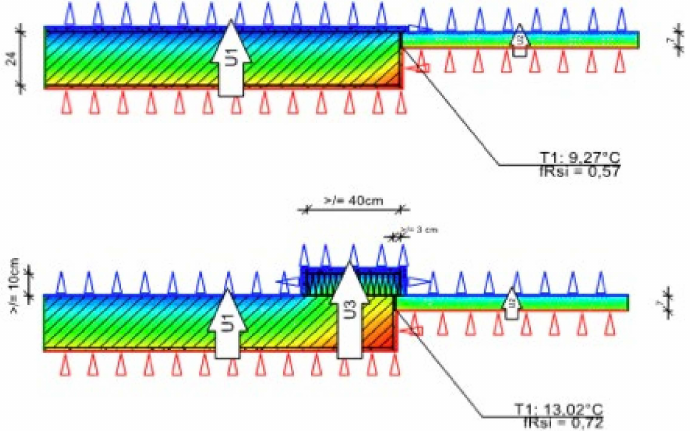
Figure A14. Before and after the thermal bridge retrofit of a window reveal (created with ThermCad the thermal bridge simulation